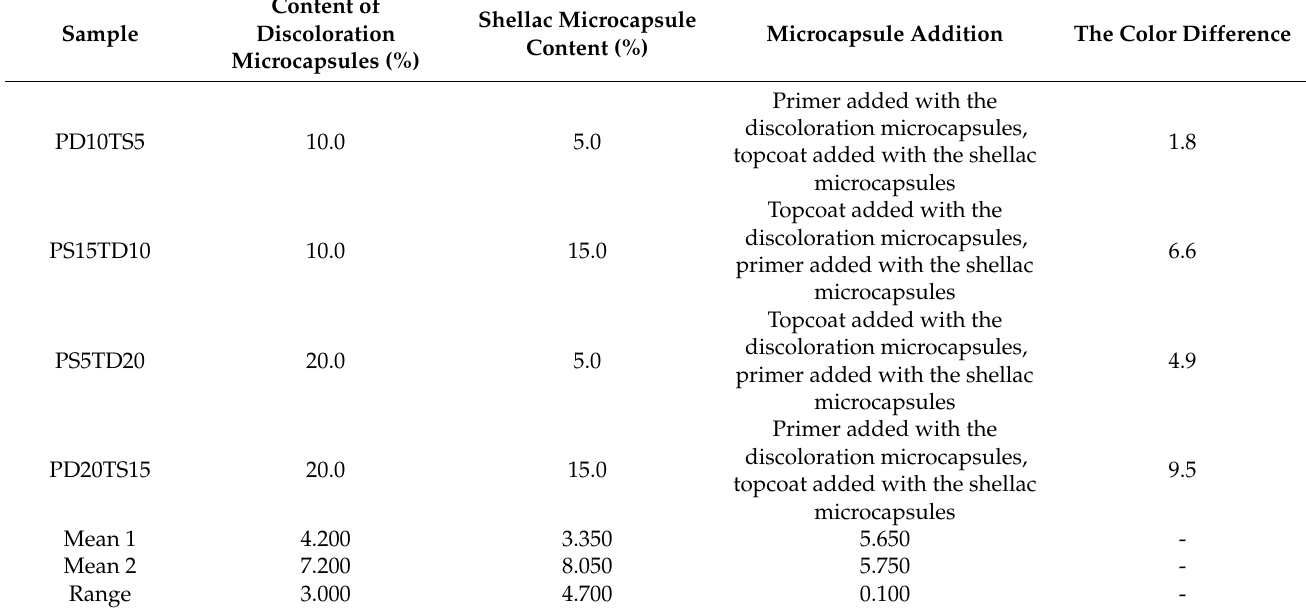
Table 3. The result of orthogonal experiment analysis.